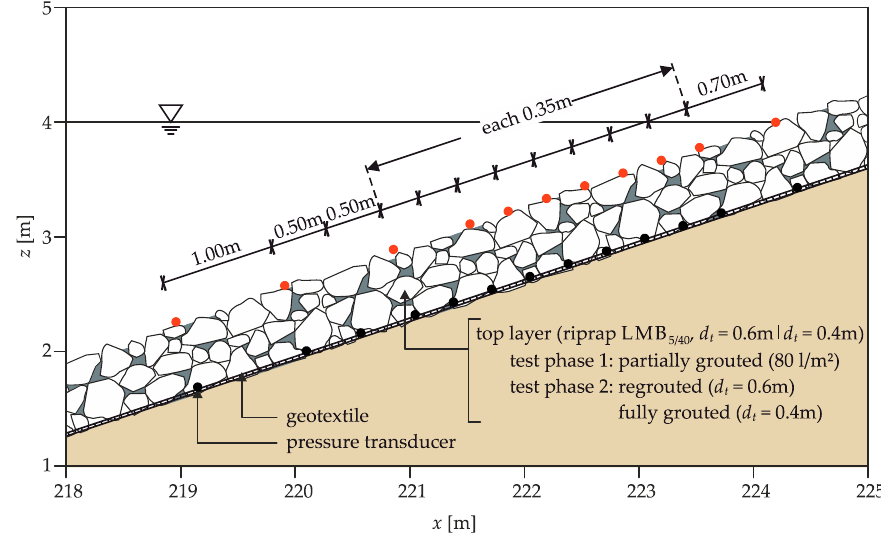
Figure 5. Position of the PTs in the GWK (after [28]).